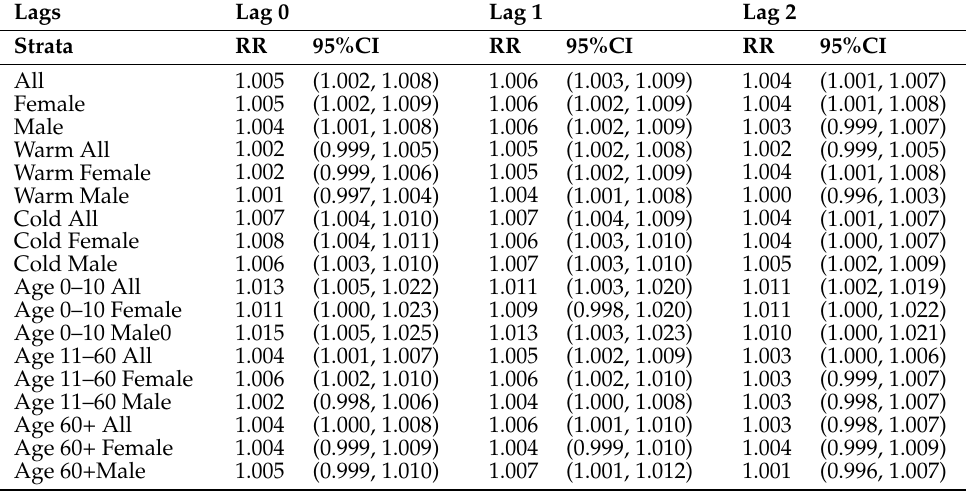
Table 5. Relative risks (RR) and their 95% confidence intervals (CI) for an increase in fine particulate XVIII Symptoms, signs and abnormal clinical and laboratory findings, not elsewhere classified. Data recorded in Toronto, Canada for the period between April 2004 and December